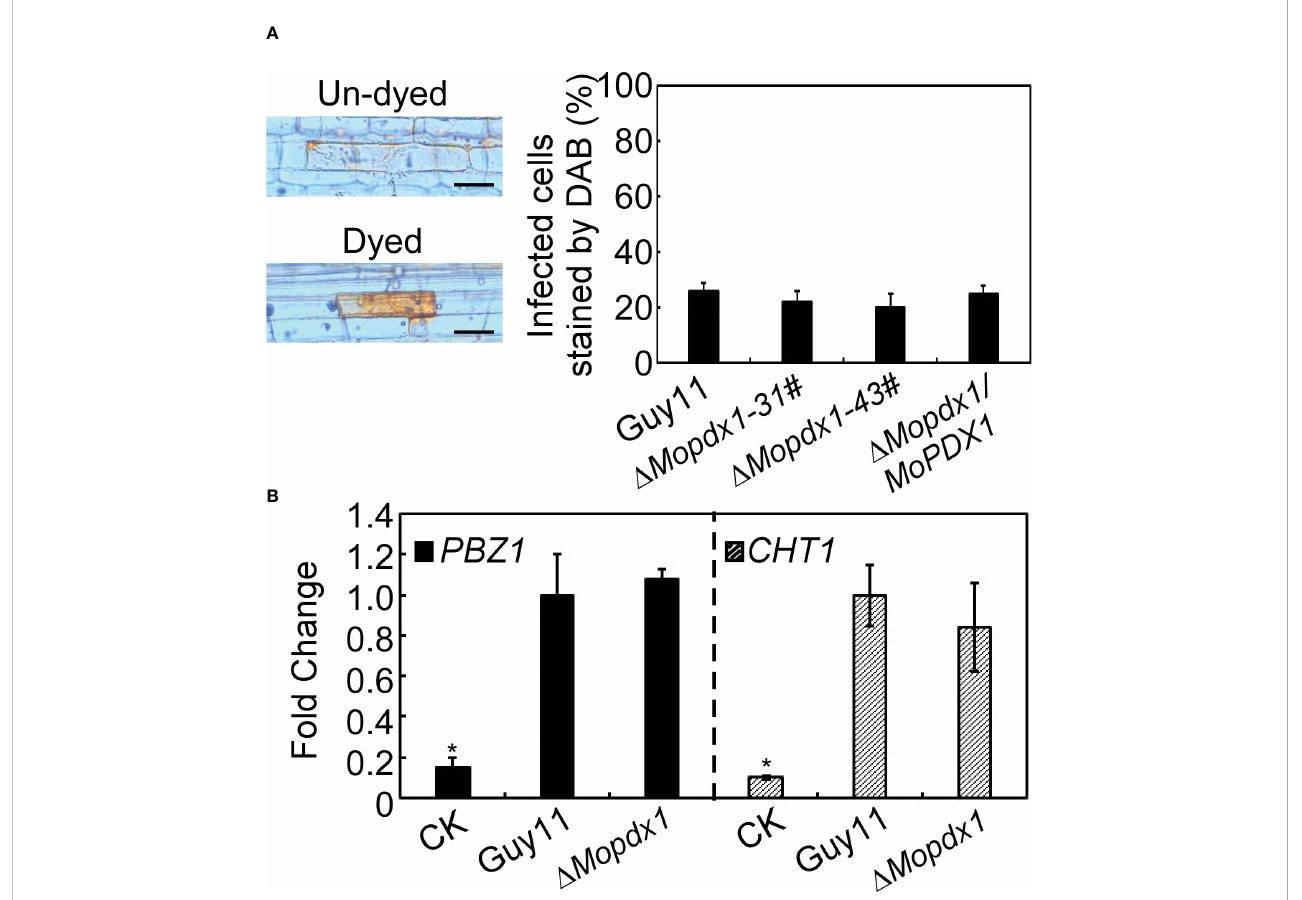
FIGURE 7 Deletion of MoPDX1 does not activate the defense response of rice. (A) Conidia suspensions (15×10 4 spores/mL) of indicated strains were injected into 21-d rice sheath cells, DAB (3,3 ’ -diaminobenzidine) was used to dye the ROS produced in rice sheath cells for 10 h at 24 hpi, and then decolorated by alcohol and acetic acid for 4 h. The left panel showed dyed or un-dyed representative photos. The right panel showed the statistical analysis. Error bars represent the standard deviation. There was no signi fi cant difference under the different treatments in indicated strains (LSD and Student-Newman-Keuls test, p <0.05). (B) Transcription analysis of the rice defense-related genes PBZ1 and CHT1 by qRT-PCR. Conidial suspensions (5×10 4 spores/mL) of Guy11 and D Mopdx1 mutants were separately sprayed onto 11-d rice CO-39 seedlings, rice leaves were collected at 48 hpi and RNA was extracted. Sterile water treatment was used as a control (CK). The stablely expressed rice gene EF1- a was used as an internal control. Error bars represent the standard deviation. Asterisks represent signi fi cant differences (LSD and Student-Newman-Keuls test, p <0.05). All experiments were performed for three independent replicates with the same